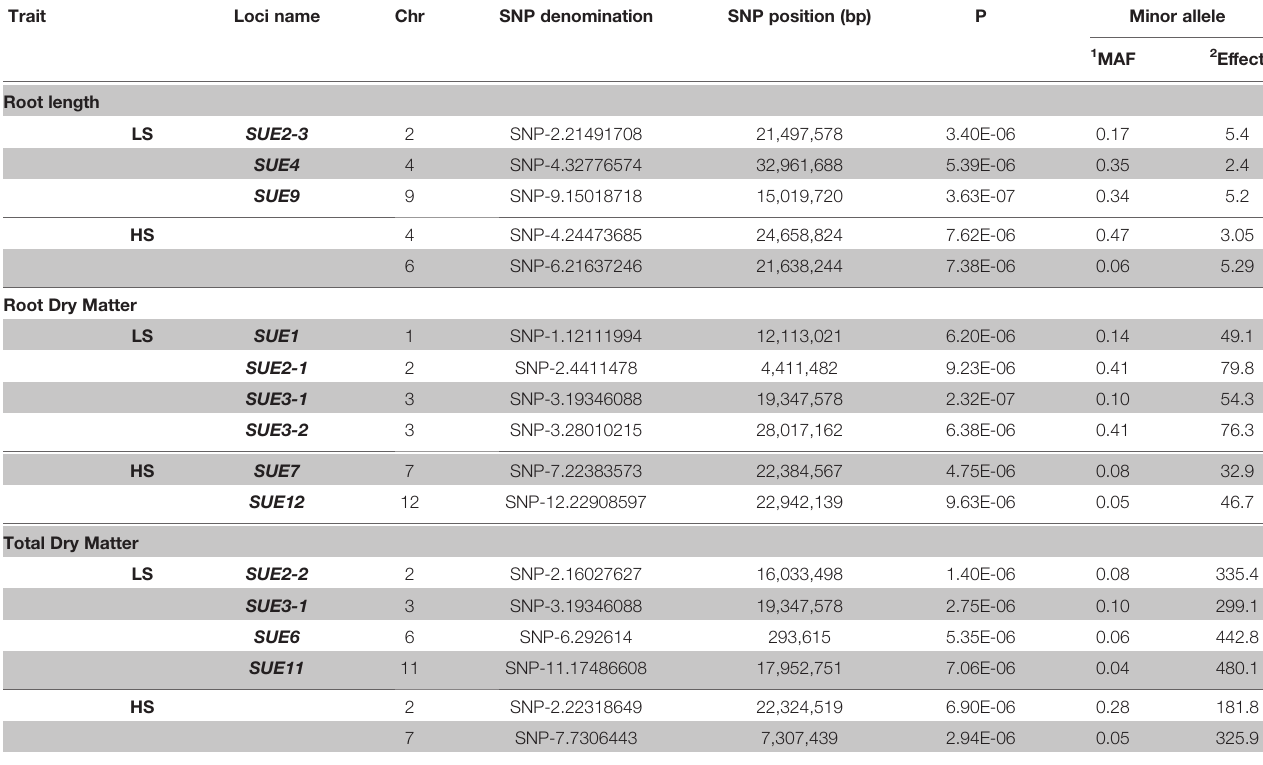
TABLE 3 | Quantitative trait loci (QTL) associated to root length, root, and total dry matter in GWAS using a mixed linear model